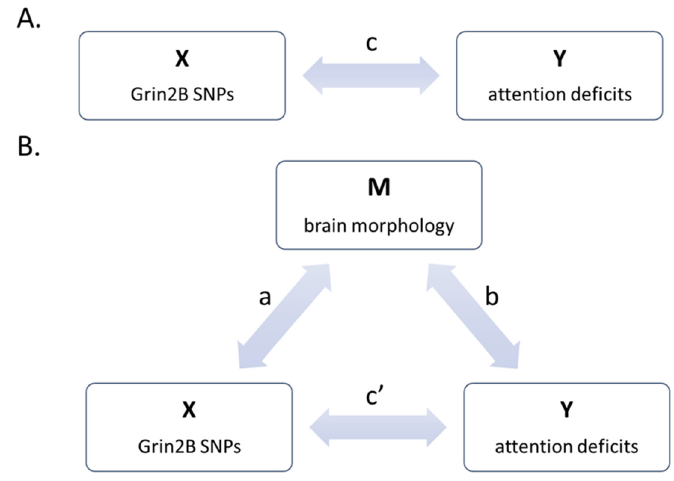
Figure 2. Mediation model design. ( A ) Model of direct effect of X on Y. ( B ) Mediation model, where X has both direct and indirect (through M) effects on Y.